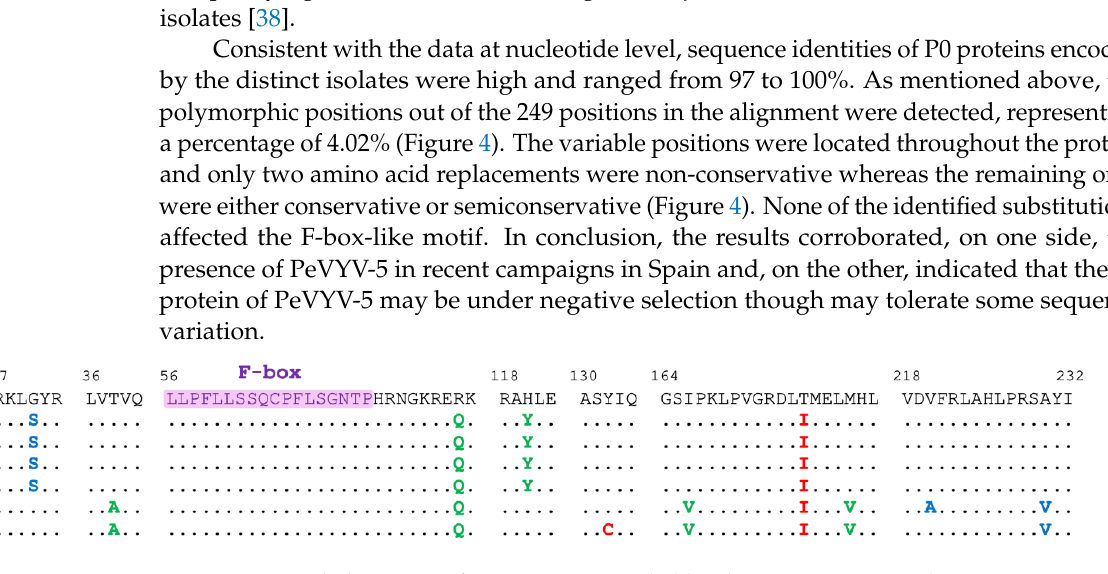
Figure 4. Partial alignment of P0 proteins encoded by distinct PeVYV-5 isolates. P0 sequence of the reference isolate [24] is depicted at the top of the alignment though only segments enclosing polymorphic residues are shown. Numbers above the reference sequence correspond to positions in the complete protein. Residues conserved in all isolates are indicated by dots. The F-box-like motif is displayed on a purple background, and non-conservative, semiconservative and conservative amino acid substitutions are shown with red, blue and green letters, respectively.